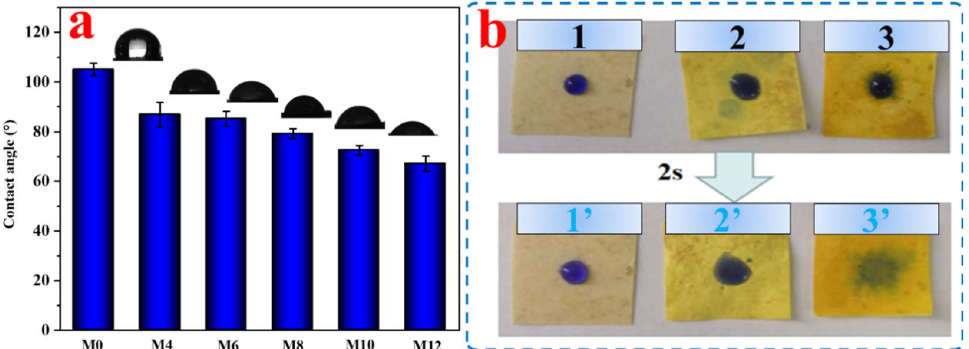
Figure 11. Wettability of ZIF-8/PPS fiber membranes. ( a ) Water contact angle of ZIF-8/PPS fiber membranes (M0: untreated; M4: 4 h; M8: 8 h; M10: 10 h; M12: 12 h); ( b ) the changes in water droplets after standing for 2 s on different surfaces (1 and 1′: untreated PPS; 2 and 2′: nitrated PPS; 3 and 3′: ZIF-8/PPS).